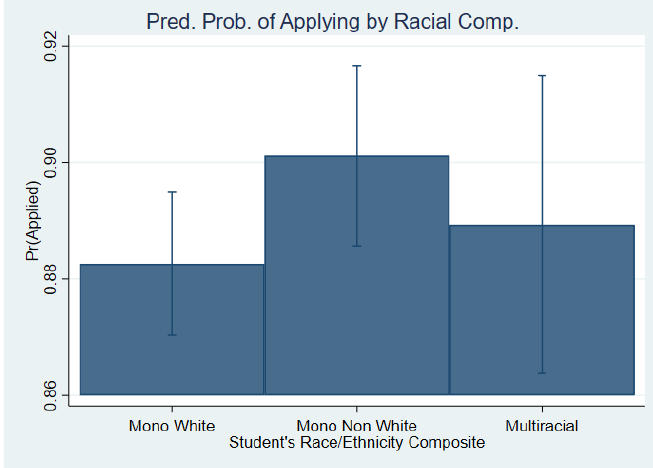
Figure 1. Pred. Prob. of Applying by Racial Comp. using ELS data.